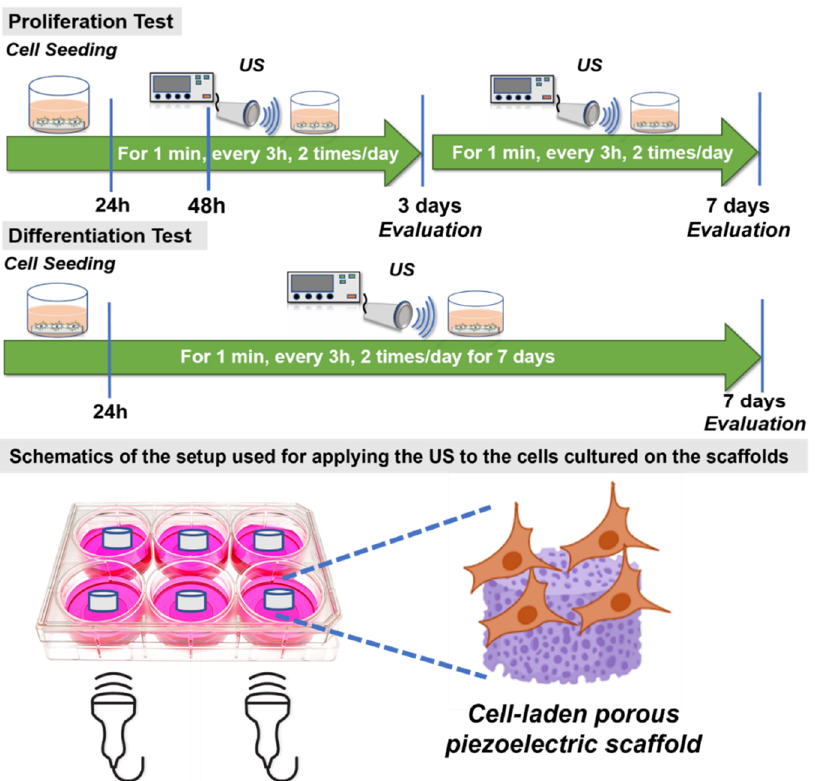
Figure 5. Schematics showing the routine for applying the US on the PCL-BT piezoelectric scaf- folds.